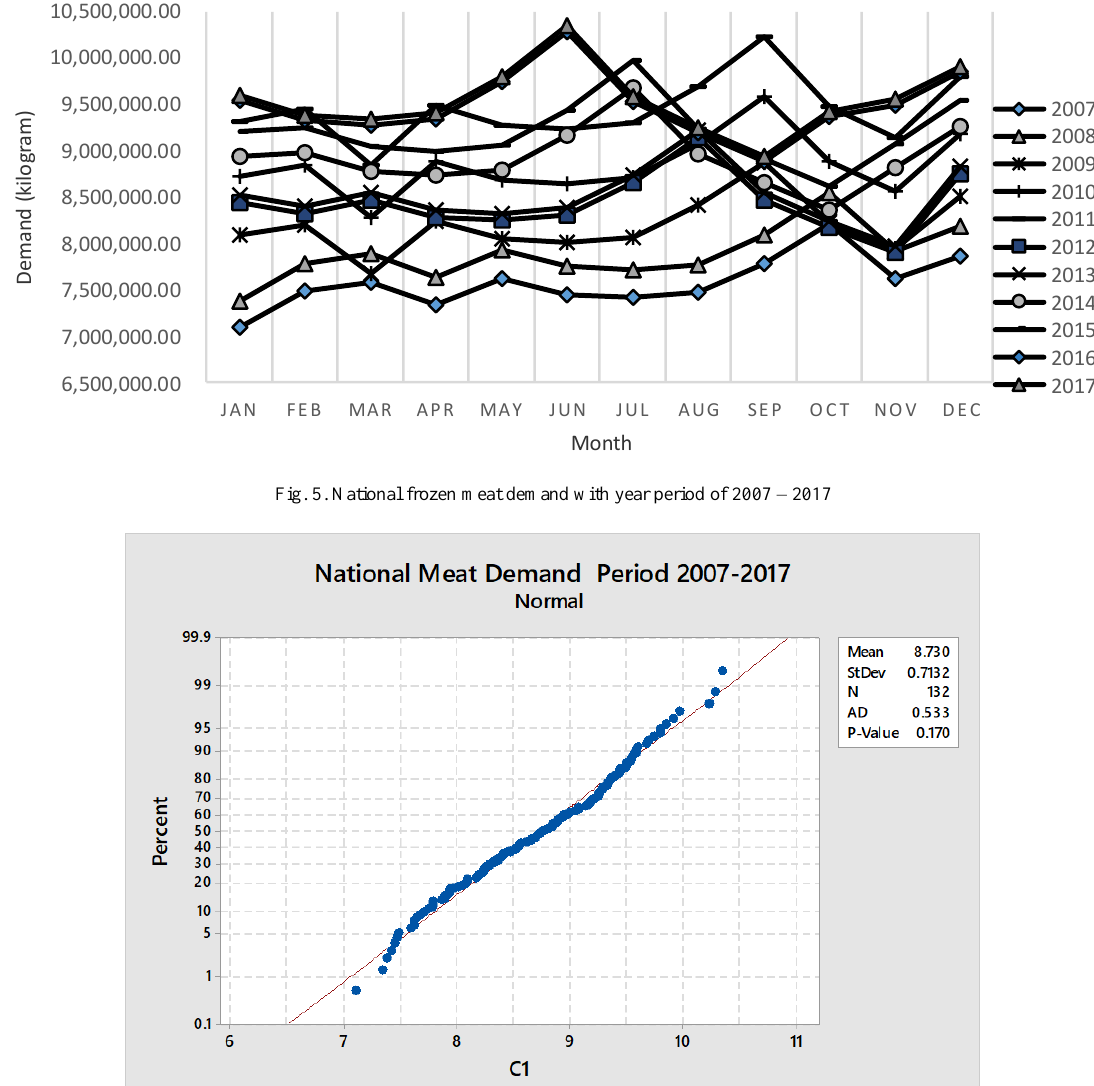
Fig. 6. Normality test of demand data output from Minitab 18 software